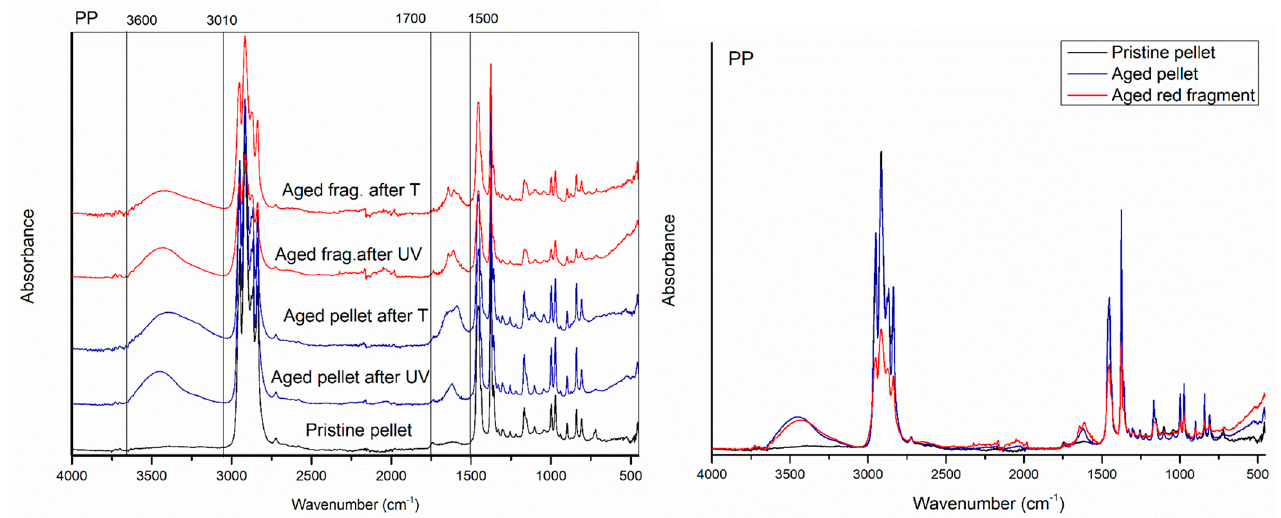
Figure 2. Comparison between the spectrum of the PP pristine pellet (black line), aged pellet (blue line), and aged red fragment (red line), after 20 days of photo-oxidation and 25 of thermos ageing in controlled conditions.